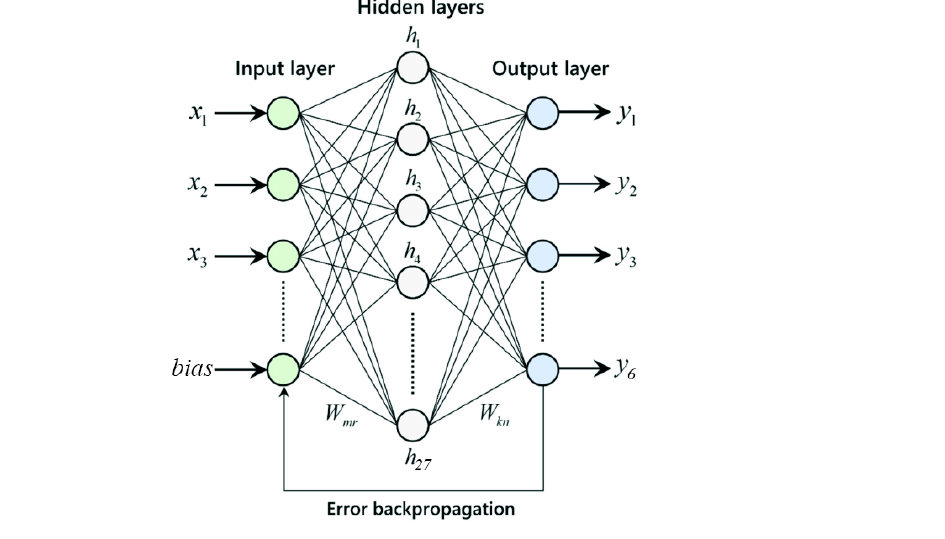
Figure 5. Architecture of the ANN with one input layer (x i ) with 3 nodes (i.e., PC, St, and Csp), one hidden layer (h i ) with 27 nodes, and one output layer (y i ) with six output nodes (i.e., r 1 , r 2 , r 3 , r 4 , r 5 , and r 6 ) (adapted by Fernández-Cabán et al., “Predicting Roof Pressures on a Low-Rise Structure from Freestream Turbulence Using Artificial Neural Networks”). Table 8. Summary of the ANN